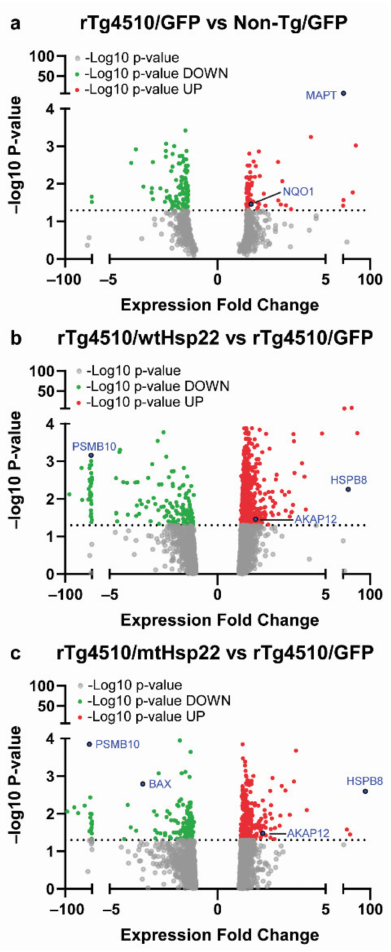
Figure 6. wtHsp22 and mtHsp22 overexpression significantly regulates key neuroprotective pro- teins. Protein-fold change was calculated using average LFQ intensities among samples where rTg4510/GFP was compared to non-transgenic (Non-Tg)/GFP, rTg4510/mtHsp22 was compared to rTg4510/GFP, and rTg4510/wtHsp22 was compared to rTg4510/GFP. ( a ) rTg4510/GFP vs. non- ) ; ( b ) rTg4510/mtHsp22 vs. rTg4510/GFP ( rTg 4510 mtHsp 22 ) ; ( c ) rTg4510/wtHsp22 Tg /GFP ( rTg 4510 GFP rTg 4510 GFP Non − Tg GFP ) . Expression-fold change values were plotted against the corre- vs. rTg4510/GFP ( rTg 4510 wtHsp 22 rTg 4510 GFP sponding –log 10 ( p -value) for each protein to generate volcano plots; horizontal dotted line represents the cutoff for statistical significance via Welch’s t -test ( p >